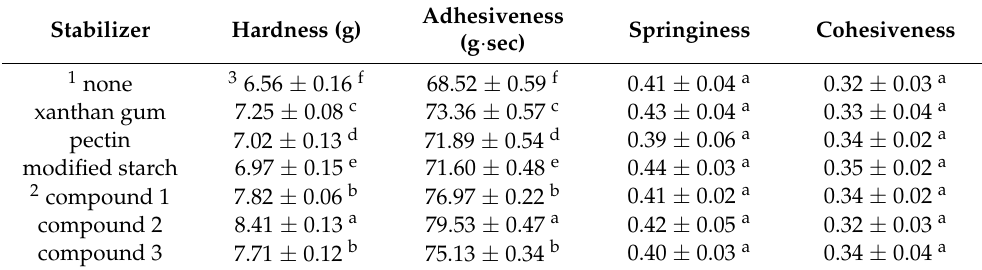
Table 1. Effect of stabilizer formulation on texture of SOB-substituted mayonnaise.